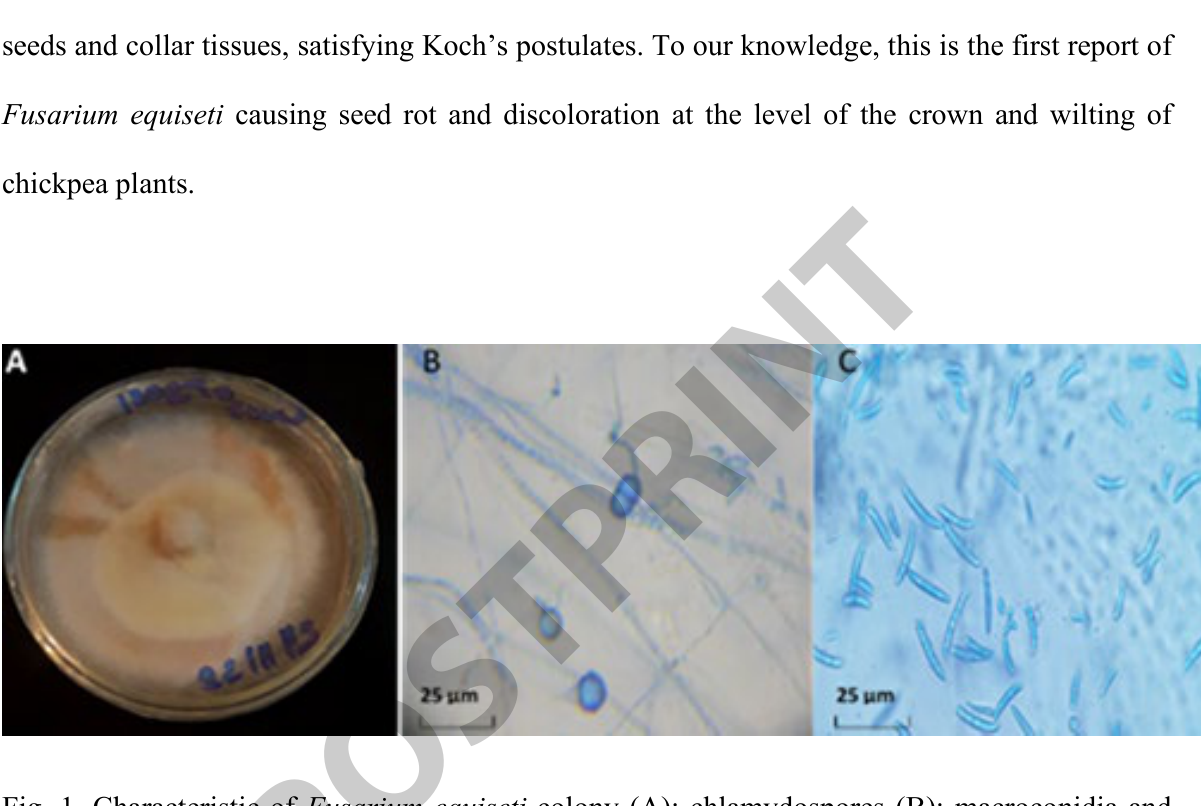
Fig. 1. Characteristic of Fusarium equiseti colony (A); chlamydospores (B); macroconidia and microconidia (C) Magnification, 400×; mounting medium, lactophenol cotton blue.